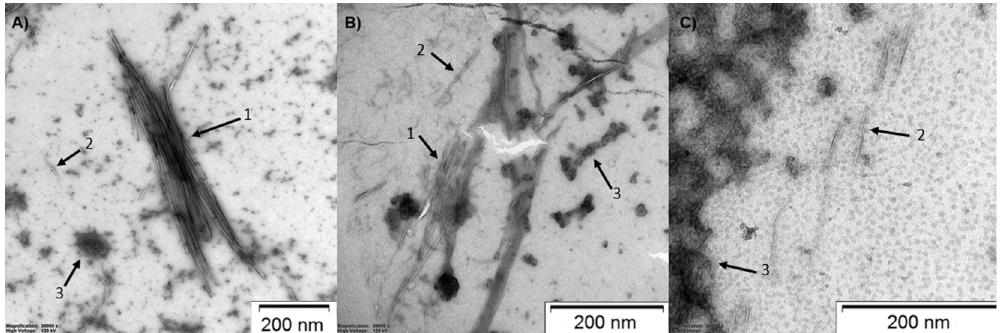
Figure 1. TEM images of ( A ) C 8 -LL-I, ( B ) C 8 -LK6, ( C ) C 10 -ATRA-1; 1—fibrils, 2—cylindrical micelles, 3—spherical or blocks of spherical micelles. Each peptide at a concentration of 2 mg/mL was incubated in the PBS buffer at 37 ◦ C by 24